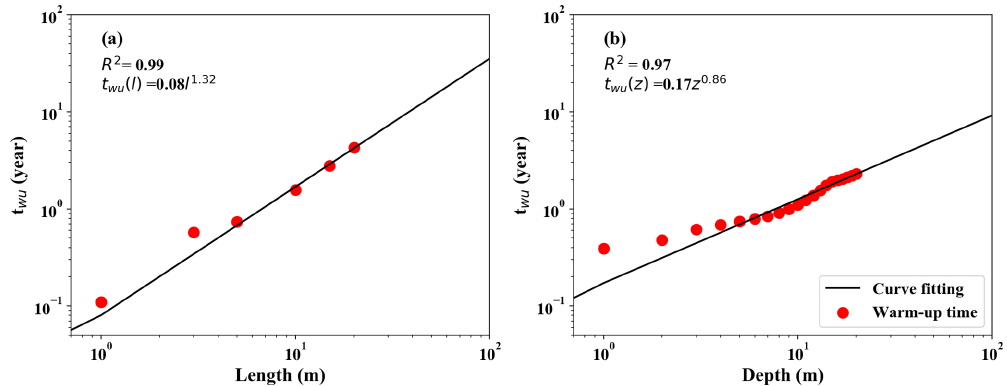
Figure 5. The value of the warm-up time t wu . (a) The overall profile t wu values versus different soil profile lengths ( l ), and (b) t wu value as a function of depth z with a 20m soil